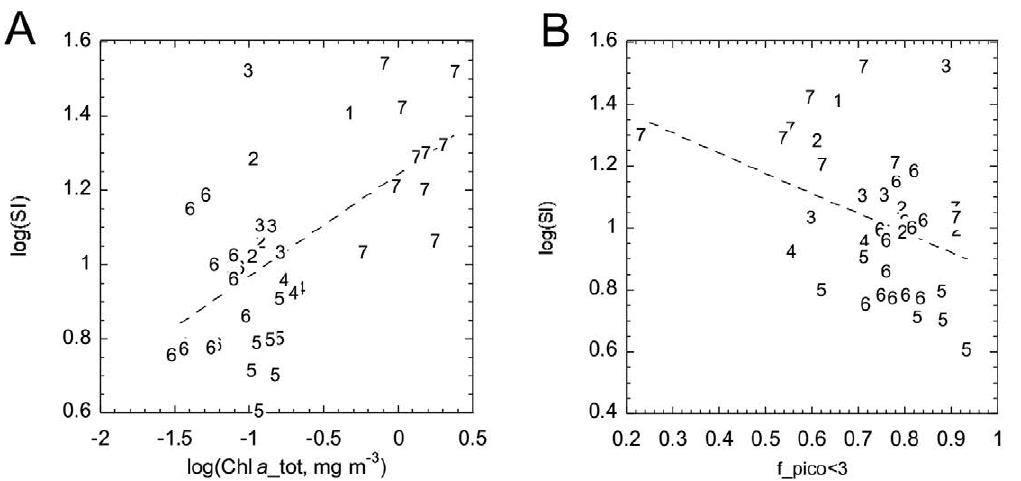
Fig. S6. – A, regression of the logarithm of the size index (SI) on log(Chl a _tot) [log(Si) = 0.28*log(Chl a _tot) + 1.24, n=41, r 2 =0.38, p<0.0001]; and B, of the logarithm of the size index (SI) on f_pico<3 [log(Si) = –0.65*f_pico<3 + 1.50, n=41, r 2 =0.14, p<0.05]. The numbers within the graph indicate the provinces (see the explanation of Table S1 for abbreviations). 1, MEDI; 2, NAST-E; 3, CNRY; 4, NATR; 5, WTRA; 6, SATL; 7,